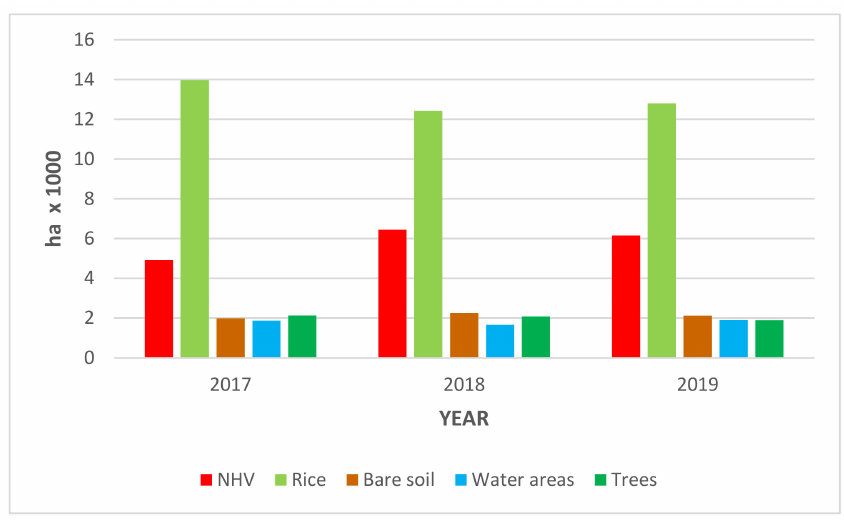
Figure 11. Land cover statistics for 2017, 2018, and 2019 rice growing seasons (NHV—natural herbaceous